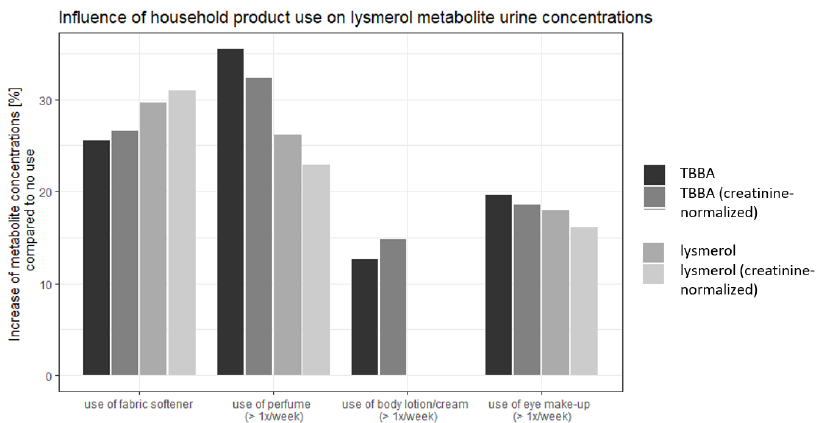
Figure 4. Results of multivariable regression: Increase in metabolite urine concentrations for use of household products compared to no use.